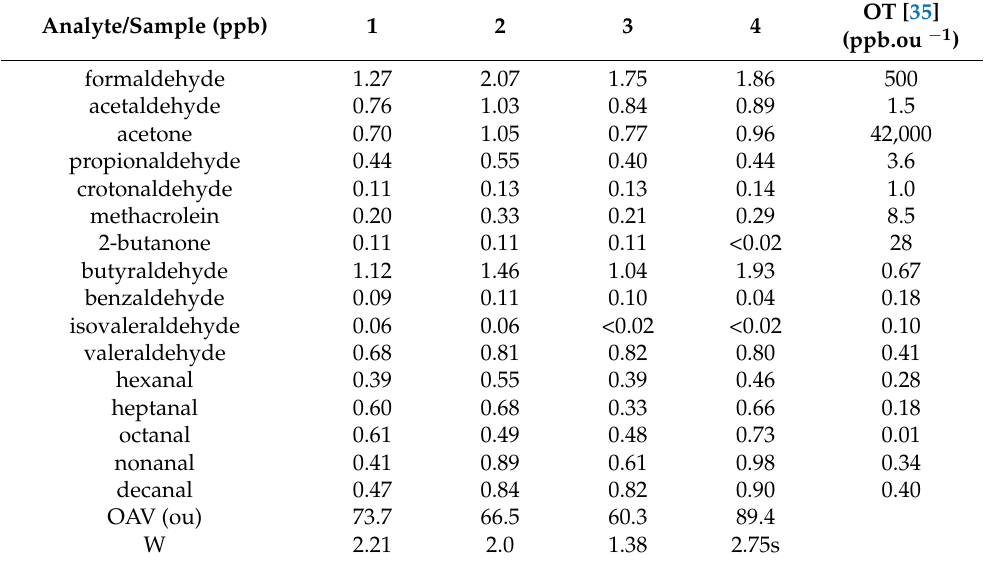
Table 6. Carbonyl concentrations (ppb) in Ú st í nad Labem and odor threshold (OT) values derived from the literature